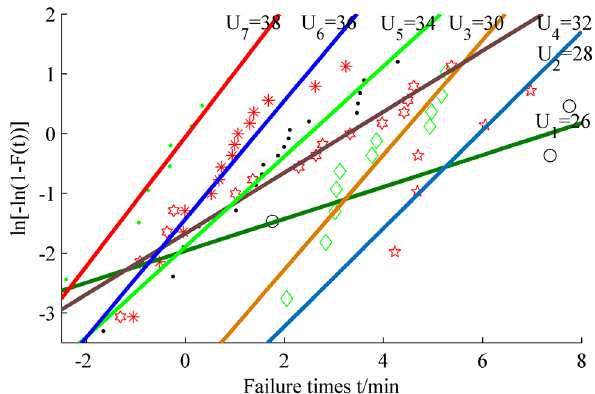
Figure 1. Probability plot under different voltages for insulating oil. Figure created using Matlab R2014a (https:// www. mathw orks. com).